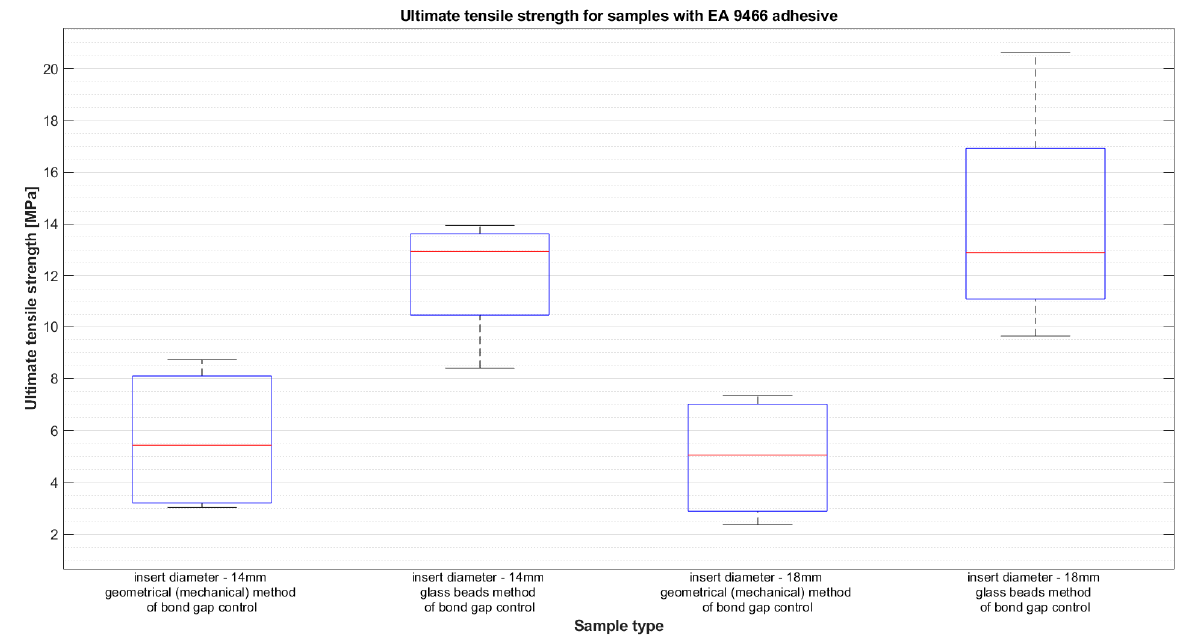
Figure 6. Ultimate tensile strength for samples with EA 9466 adhesive.